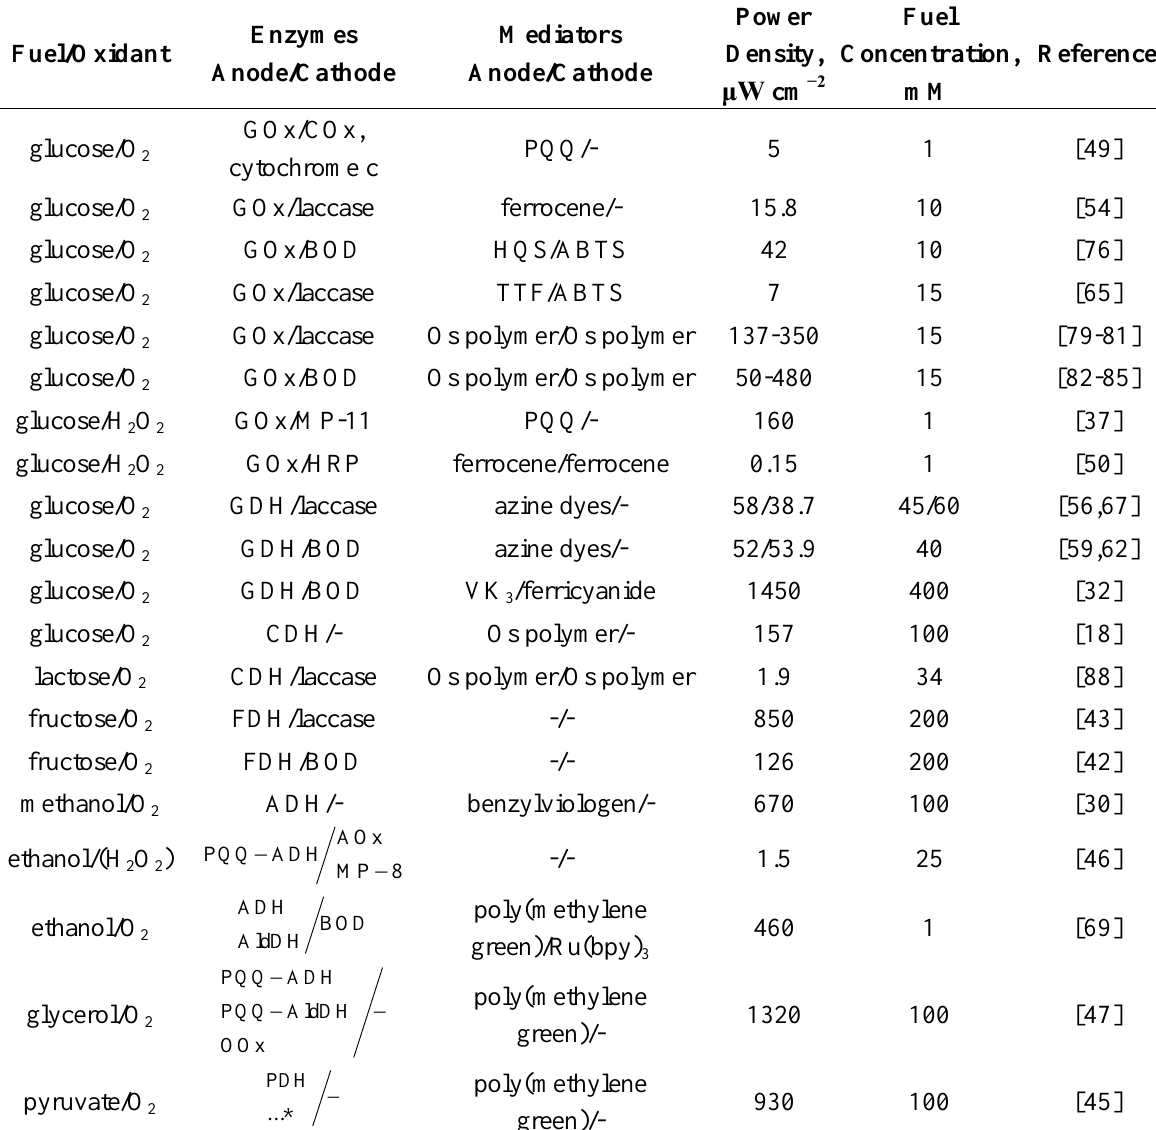
Table 7. Examples of enzymatic biofuel